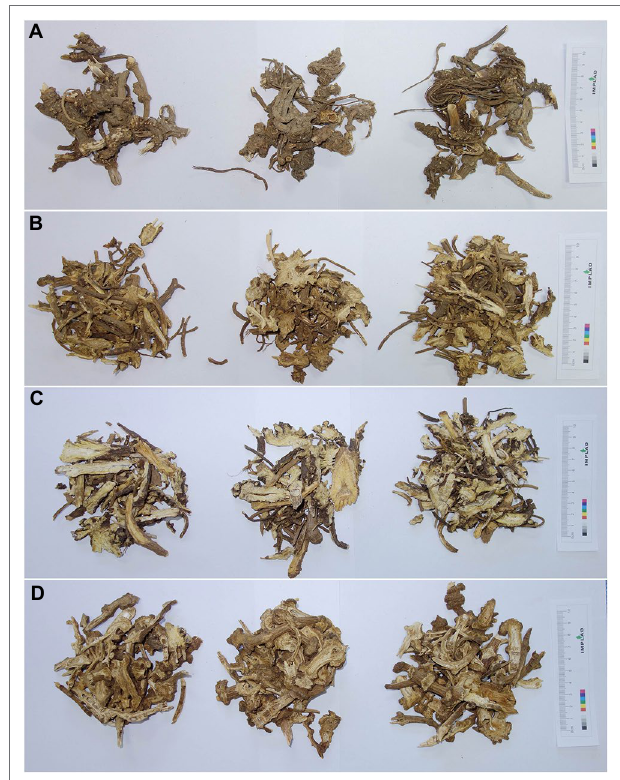
FIGURE 1 | Gaoben-related medicinal materials in the market (A) Ligusticum sinense , (B) Ligusticum jeholense , (C) Conioselinum vaginatum , and (D) Ligusticum